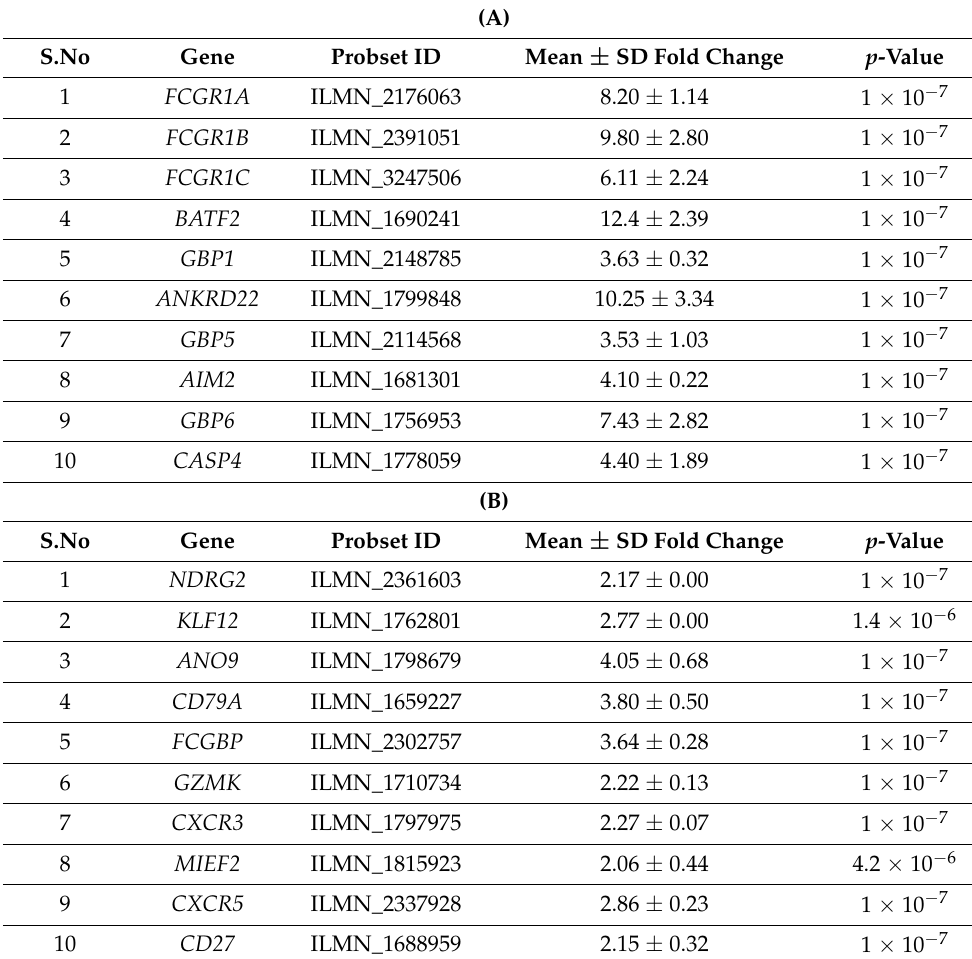
Table 1. ( A ) Top 10 upregulated genes in ATB vs. LTBI. ( B ) Top 10 downregulated genes in ATB vs.